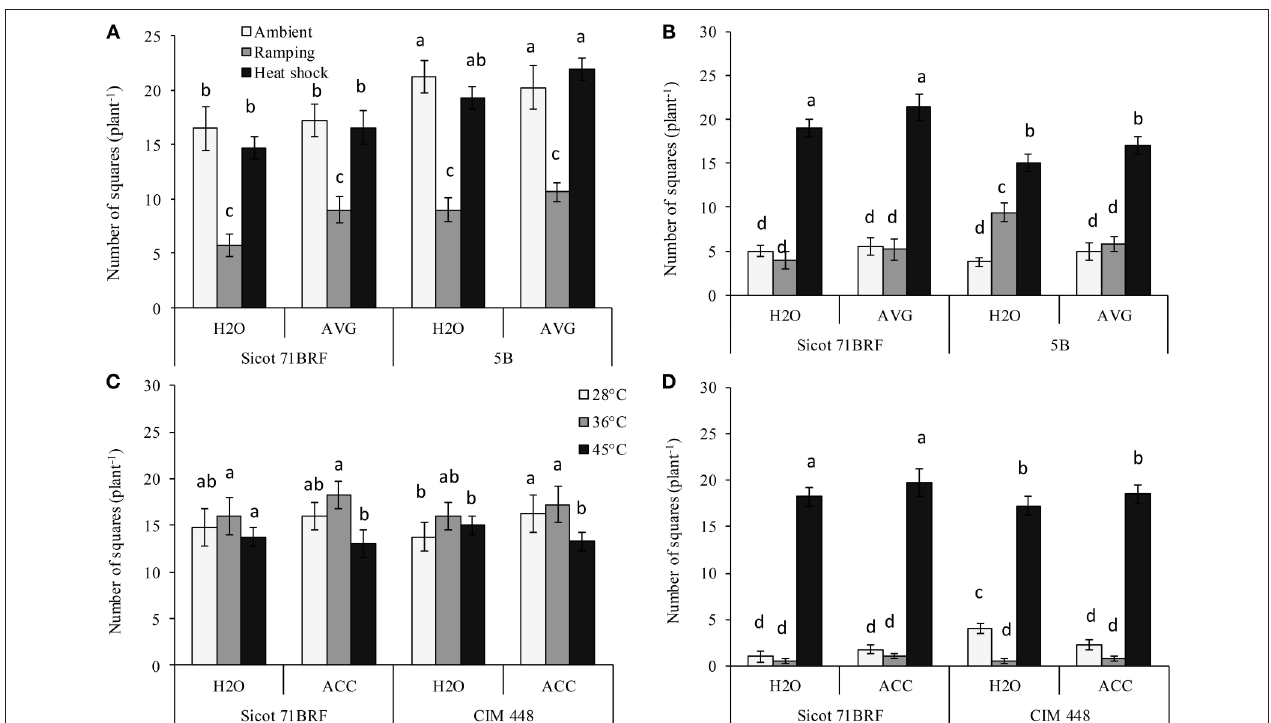
FIGURE 2 | Effect of aminoethoxyvinylglycine (AVG) on the number of squares (non-pollinated flowers) in cotton genotypes Sicot 71BRF and 5B exposed to heat shock (45 ◦ C) and ramping heat (gradual rise in temperature to 45 ◦ C) for 7 days. Data were collected (A) on the last day of heat treatment and (B) 15 days of recovery after the heat treatment. Values are the mean of four independent replications, with the error bars representing SE and sample size = 4. Effect of 1-aminocyclopropane-1-carboxylic acid (ACC) on the number of squares in cotton genotypes Sicot 71BRF and CIM 448 exposed to heat shock (45 and 36 ◦ C) for 7 days. Data were collected (C) on the last day of heat treatment and (D) 15 days of recovery after the heat treatment. Values are the mean of four independent replications, with the error bars representing SE and sample size = 4. Means sharing same letters within each figure are not significantly different at α =